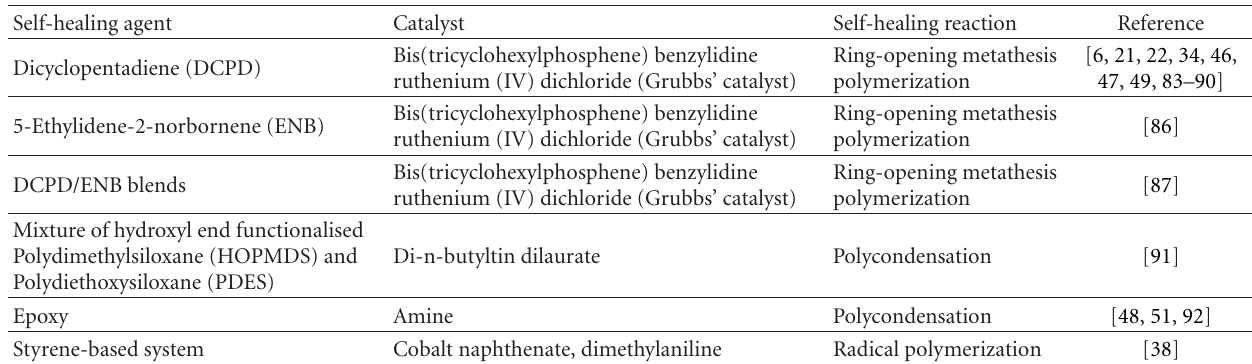
Table 2: Literature summary of self-healing chemicals investigated for the microencapsulation approach. Adapted from